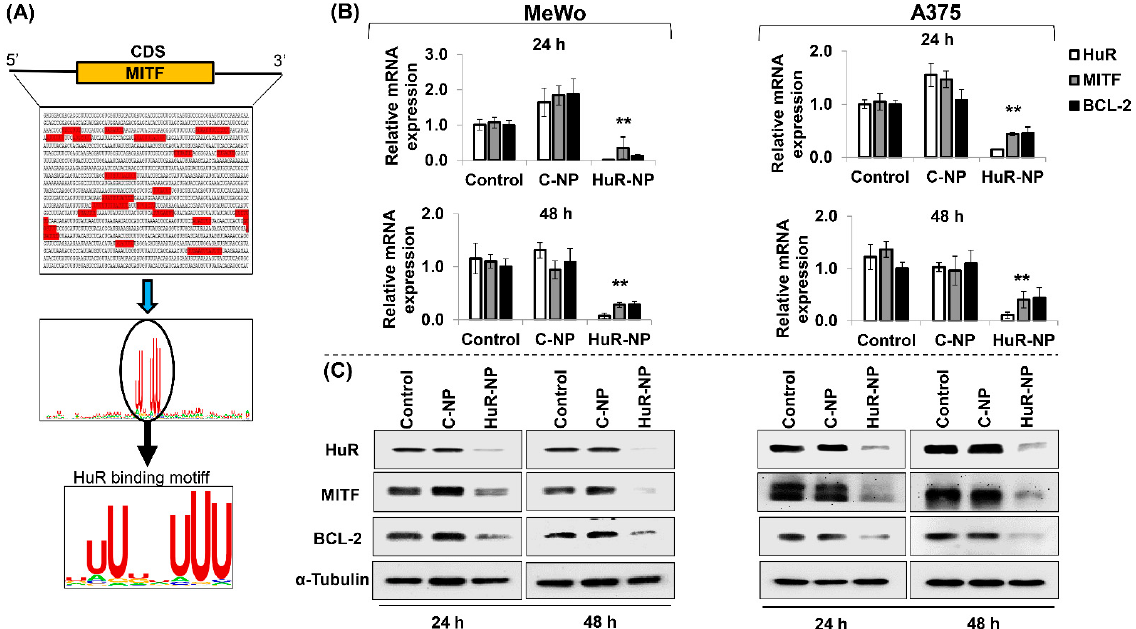
Figure 6. HuR-NP attenuates MITF mRNA and protein expression. ( A ), The MITF gene sequence, including promoter, untranslated regions (UTRs), and coding sequence (CDS), were scouted for HuR binding site. Multiple HuR binding sites were observed along the MITF gene. The conserved sequence search indicates HuR binding motif (5 ′ NNUUNNUUU3 ′ ) conserved across the MITF gene sequence. RBPmap (http://rbpmap.technion.ac.il/) [51] and WebLogo (https://weblogo.berkeley.edu/) [52] available in the public domain as open resource tools were used for the analysis. The HuR-MITF binding was validated by ( B ), qRT-PCR, and ( C ), Western blot analysis in C-NP, and HuR-NP-treated MeWo and A375 melanoma cells. Untreated cells served as controls for each cell line. BCL-2 was assessed as positive control and downstream transcriptional target of MITF. 18S forward and reverse primers, and alpha α -Tubulin were used as internal controls in qRT-PCR and Western blotting, respectively. Error bar denotes SD; ** p < 0.01.